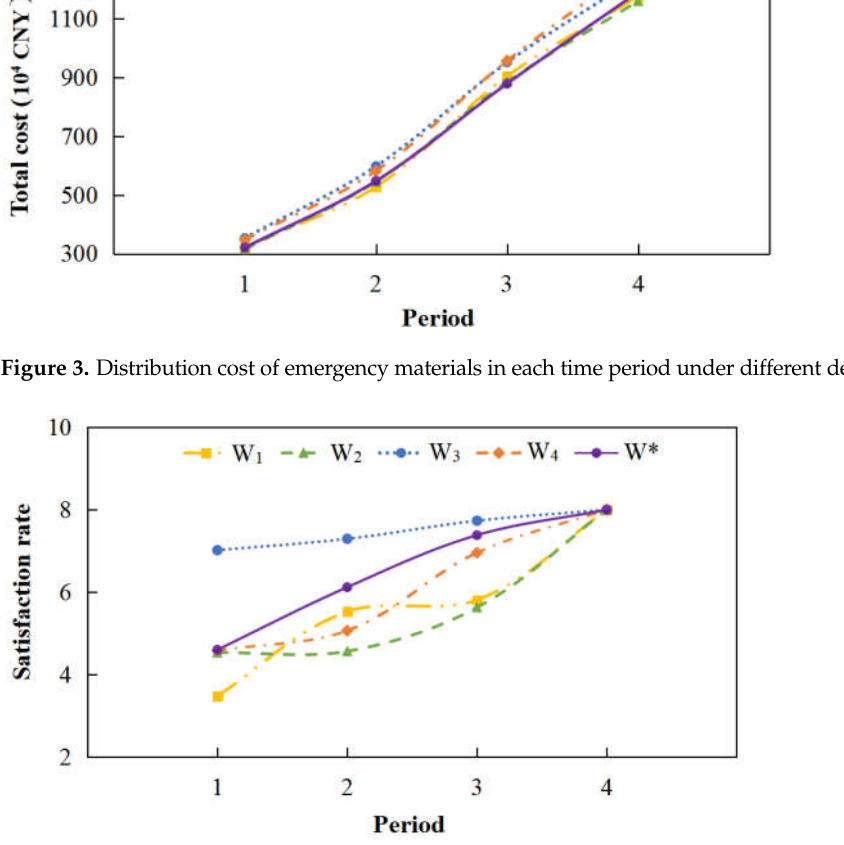
Figure 4. Satisfaction rate of emergency material distribution in each time period under different decision criteria.